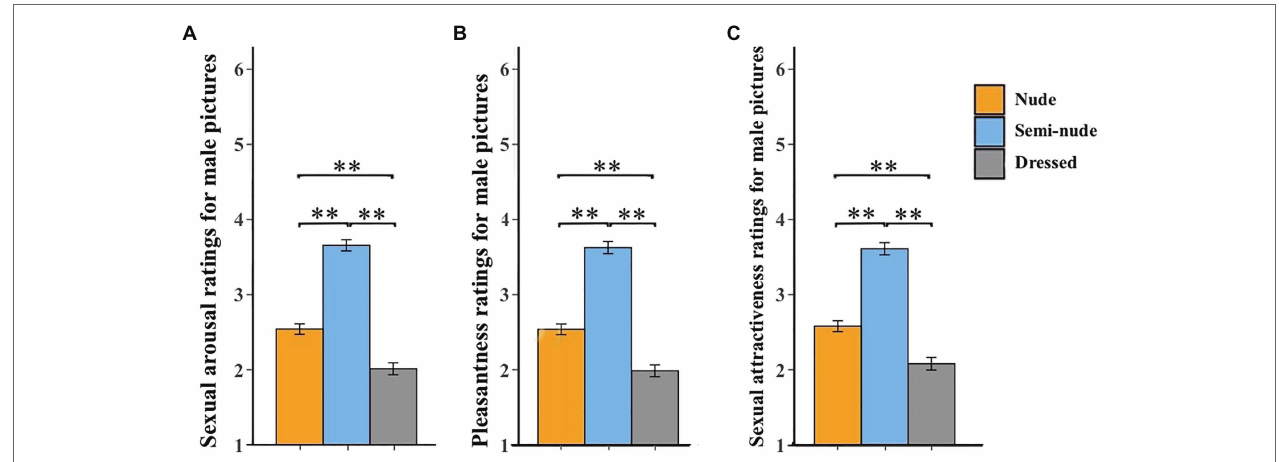
FIGURE 2 | Females’ ratings of sexual arousal (A) , pleasantness (B) , and sexual attractiveness (C) for male pictures. Error bars represent standard errors of the mean. ** p <